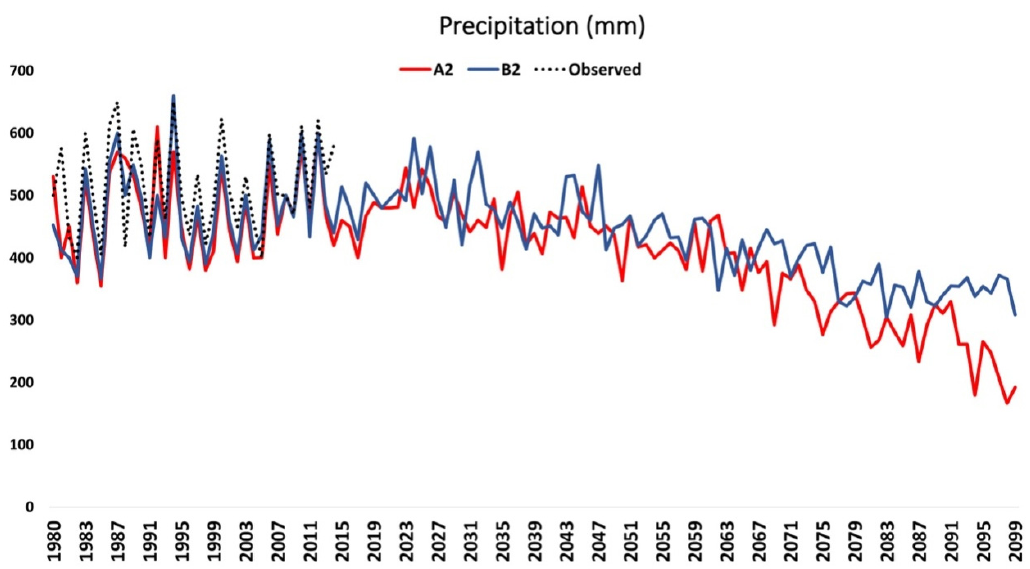
Figure 4. Projected precipitation for the future period until 2100. Table 3. Projected changes in average annual precipitation, T-max and T-min ( ◦ C), compared to baseline period in Ourika